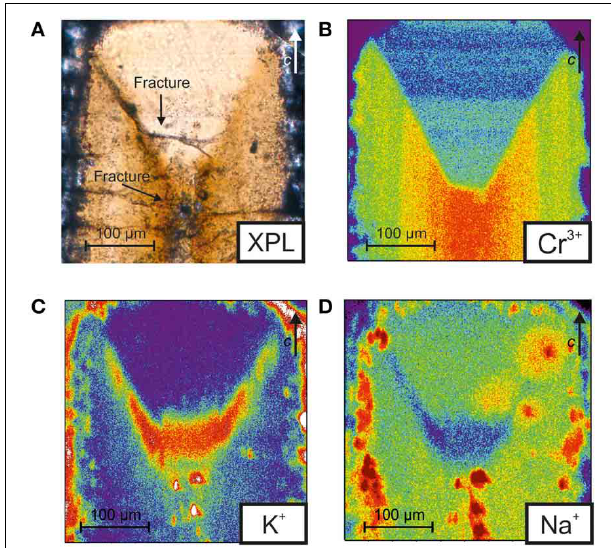
FIGURE 3 | (A) Crossed polars optical image (XPL) and (B–D) TOF-SIMS images of the studied beryl sample after the experimental run. The color scale is proportional to the element contents from red (high) to blue